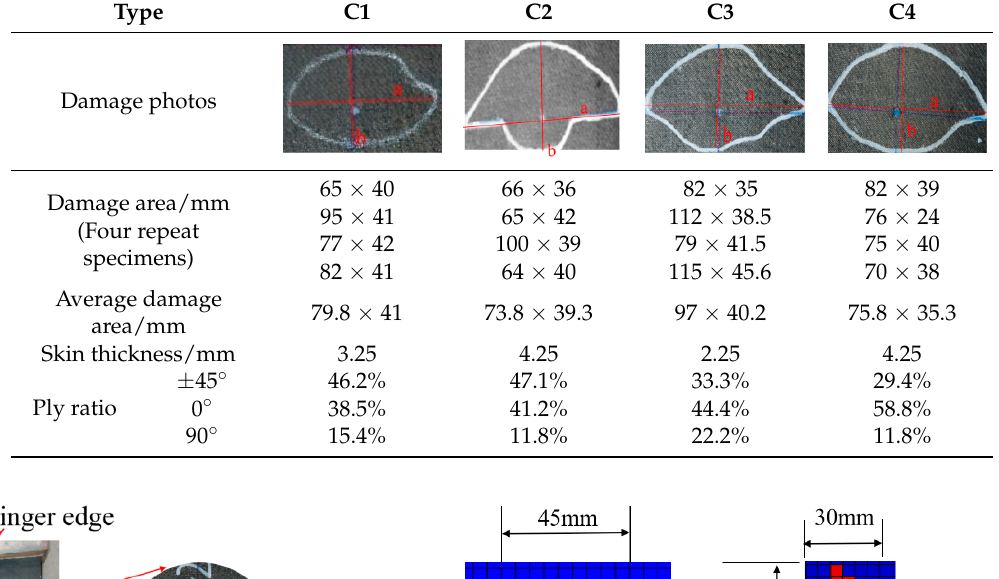
Table 6. Impact damage photos and area.